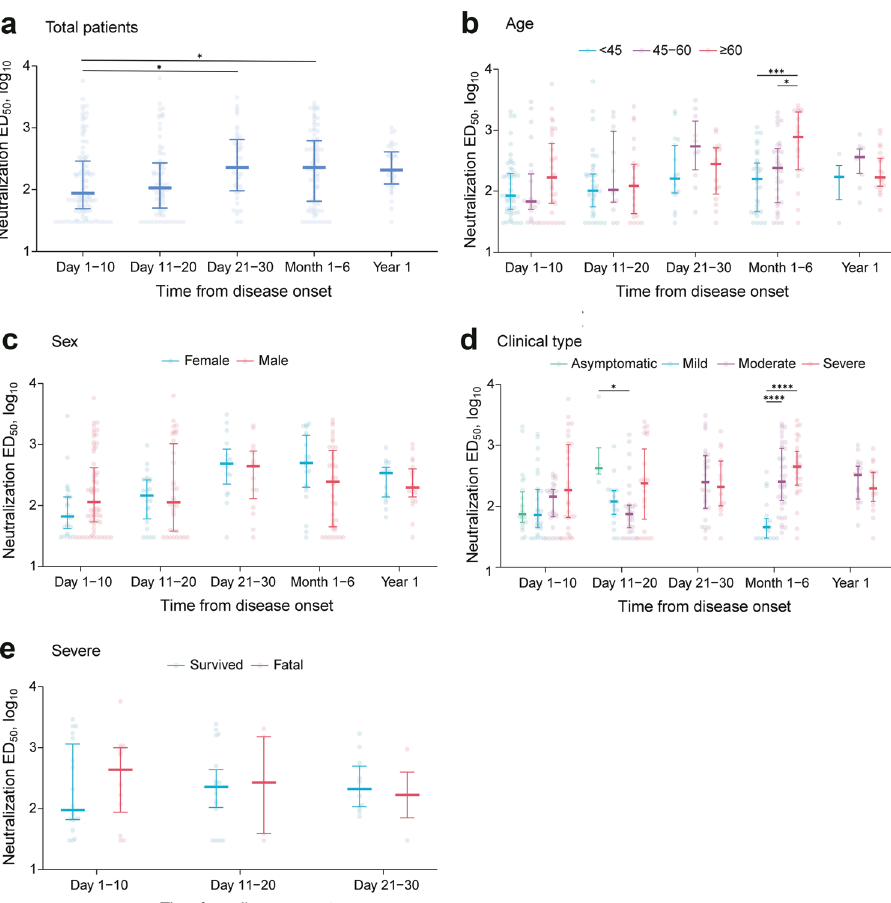
Fig. 2 Neutralization antibodies in COVID-19 patients over time. a Total patients ( n = 255). b Patients strati fi ed by age groups (97 patients were <40 years old; 74 patients were 40 – 60 years old; 84 patients were ≥ 60 years old). c Patients strati fi ed by sex (164 males and 91 females). d Patients strati fi ed by clinical phenotype (21 asymptomatic, 58 mild, 94 moderate, and 82 severe). e Patients strati fi ed by clinical outcomes (30 survived and 19 fatal). Dots represent values (log 10 -transformed) for individual detection, and lines and error bars indicate the median and interquartile range, respectively. In a , c , e , Mann – Whitney U test was performed. In b , d , the multiple comparisons among the groups were made using Kruskal – Wallis test followed by Bonferroni post hoc correction; * P < 0.05, *** P < 0.001, **** P < 0.0001. COVID-19